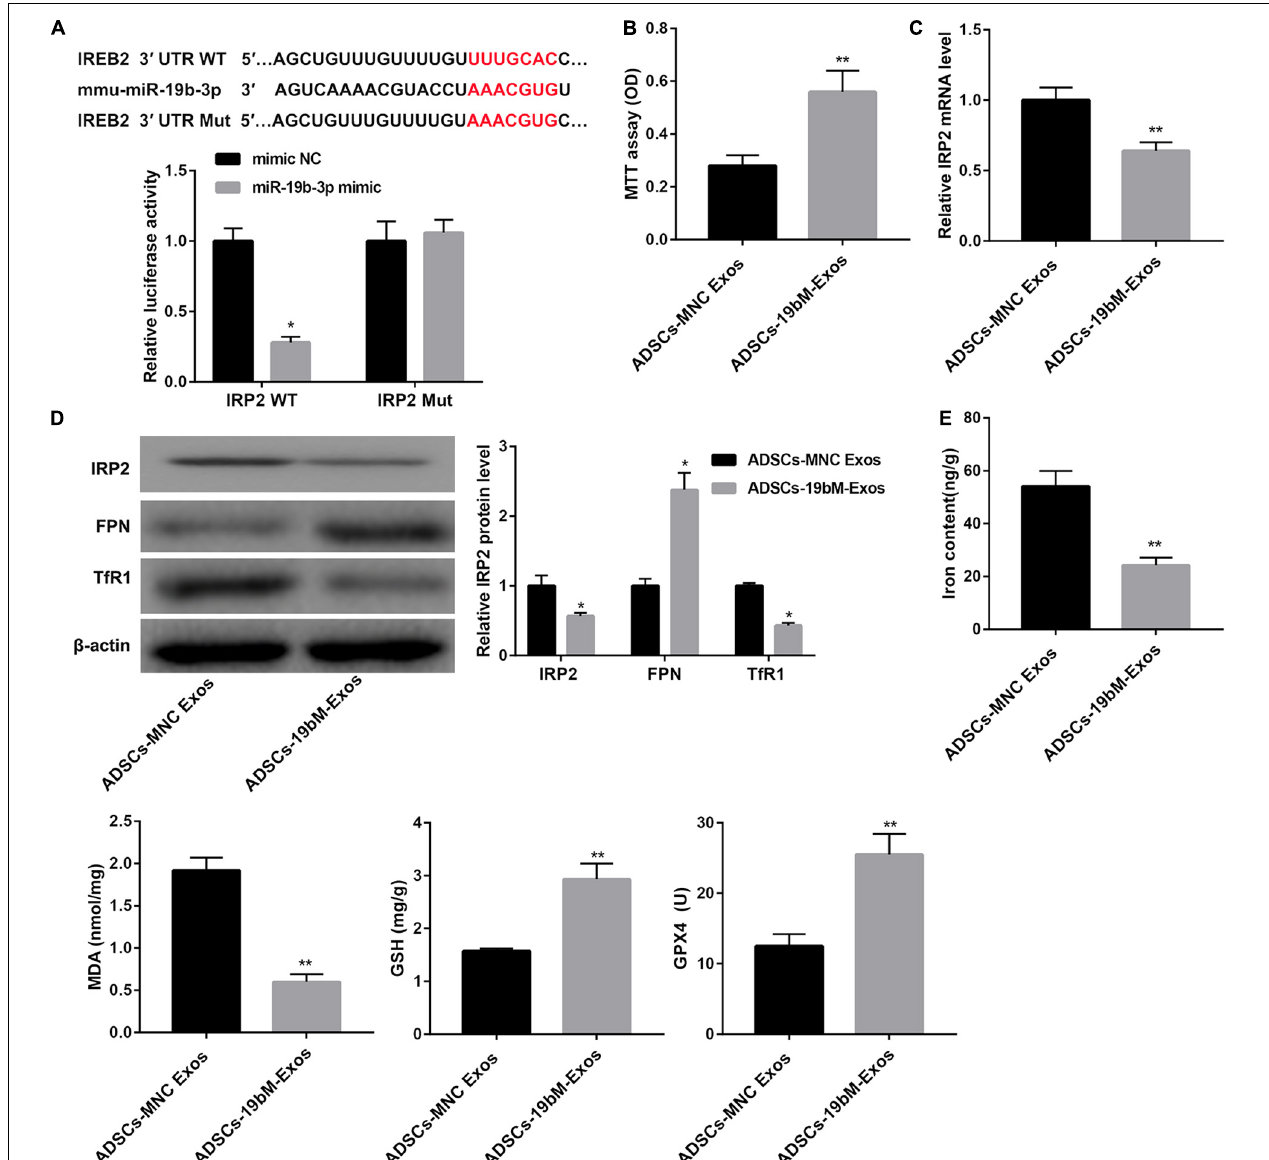
FIGURE 4 | Exosomal miR-19b-3p derived from ADSCs abrogated hemin-induced ferroptosis. (A) The putative miR-19b-3p binding sites in IRP2 (IRP2-WT) or and the designed mutant sequence (IRP2-Mut) were indicated. Luciferase reporter assay was conducted to evaluate the interaction ability between IRP2 3 (cid:48) -UTR and miR-19b-3p. (B) Cell viability examined MTT assay. (C) qRT-PCR analysis of IRP2 mRNA level, (D) western blot analysis of IRP2, TfR1, and FPN, and (E) levels of iron, MDA, GSH, and GPX4 in the primary cortical neurons which were co-cultured with ADSCs-MNC-Exos or ADSCs-19bM-Exos and hemin (100 µ M) for 24 h. The data are presented as the mean ± standard deviation ( n = 3). * P < 0.05, ** P < 0.01, vs. mimic NC or